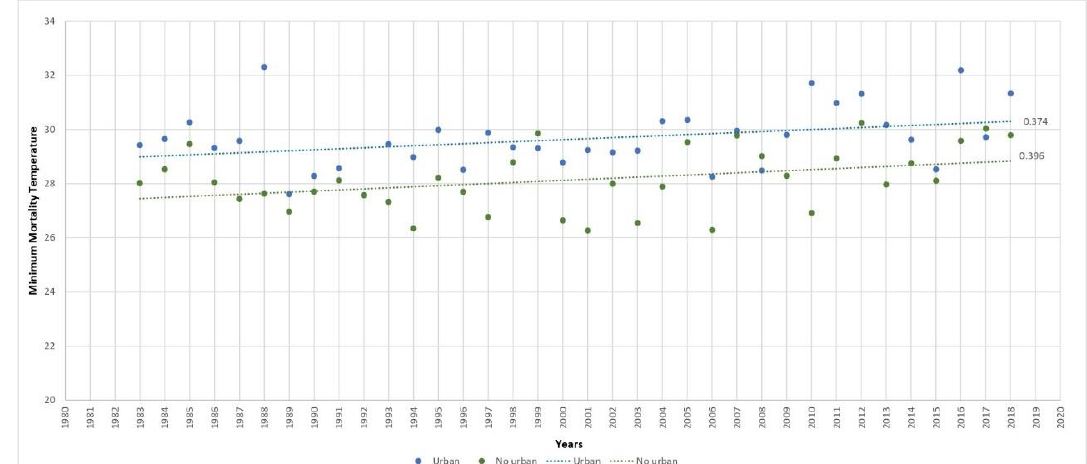
Int. J. Environ. Res. Public Health 2023 , 20 , x FOR PEER REVIEW 8 of 12 Figure 2. Trend in minimum mortality temperature (MMT) by year and type of territory in Spain (1983–2018).